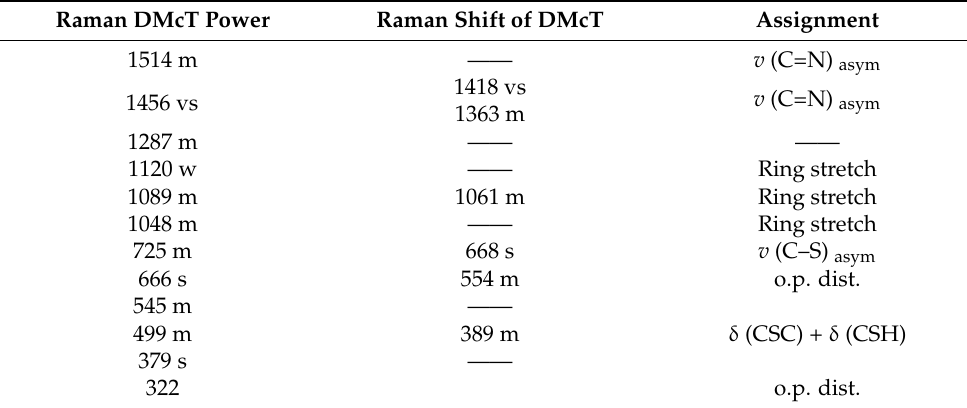
Figure 5. The Raman spectrum and standard curve for the detection of Hg 2+ based on Fe 3 O 4 @SiO 2 @AuNPs-DMcT SERS probes. ( A ) Raman spectra of the reaction between different concentrations of Hg 2+ and Fe 3 O 4 @SiO 2 @AuNPs-DMcT SERS probes; ( B ) linear relationship between Hg 2+ concentration and SERS peak intensity at 1418 cm − 1 for DMcT. (R-R 0 , R, and R 0 represented the SERS intensity of DMcT at 1418 cm − 1 when Hg 2+ was present or absent). Table 1. Spectral data and vibrational assignment of DMcT.